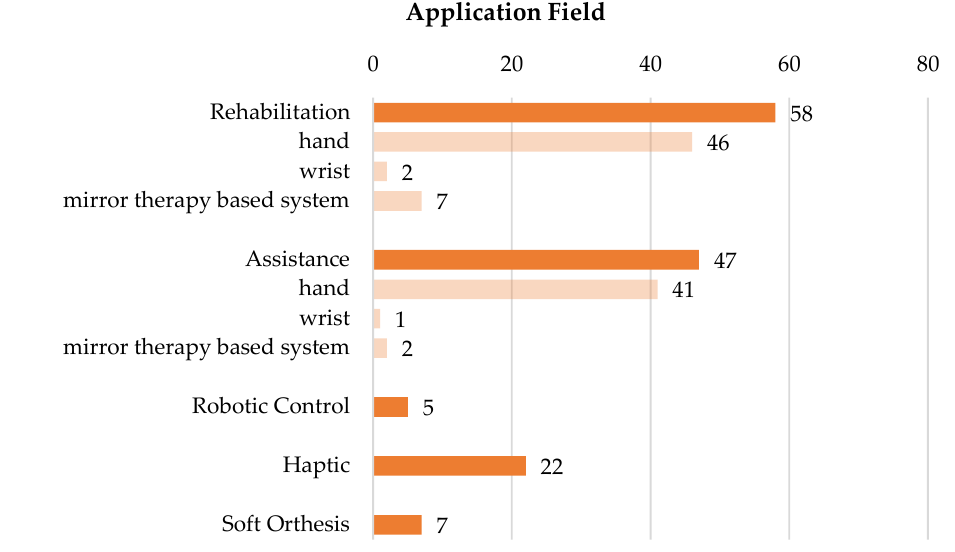
Figure 9. Distribution of the soft gloves among application fields.